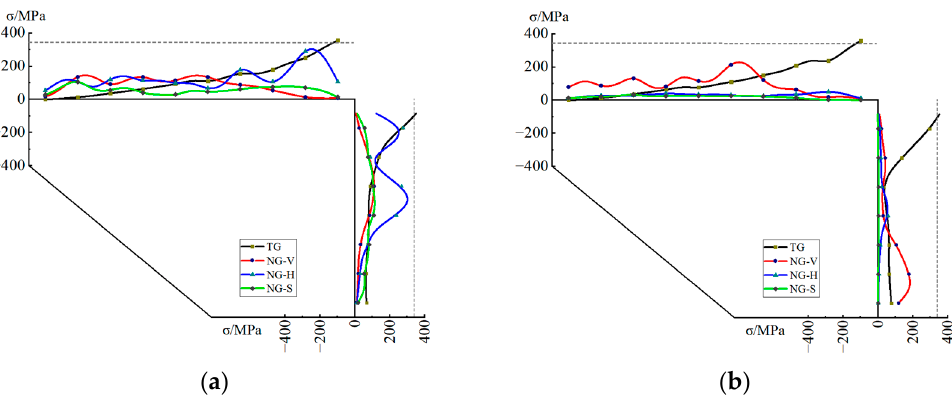
Figure 13. The Von Mises stress responses along the gusset interfaces at 2% drift: ( a ) Joint closing; ( b ) Joint opening. ( b ) Joint